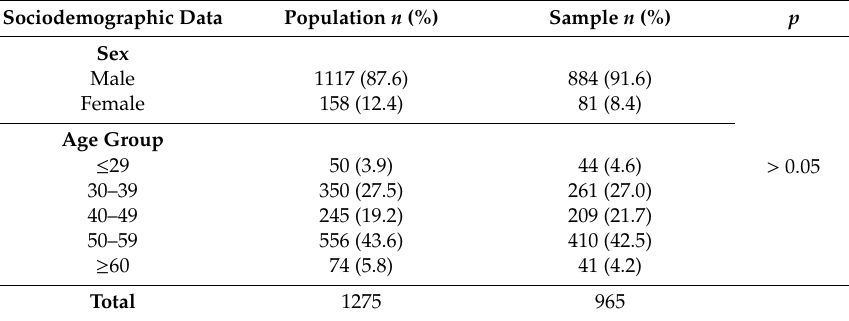
Figure 1 Detailed the Interdisciplinary Worker’s Health Approach Instrument (IWHAI) development and validation process.